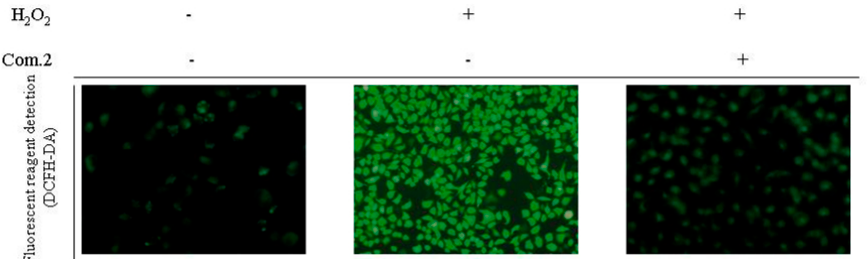
Figure 5. Compound 2 reduced the amount of intracellular reactive oxygen species (ROS). Cells were treated with 100 μ M of compound 2 for 4 h, then exposed to 200 μ M H 2 O 2 for 12 h. Cells were stained with dichloro-fluorescein-diacetate (DCFH-DA). The DCF fluorescence intensity was measured by fluorescence microscope.